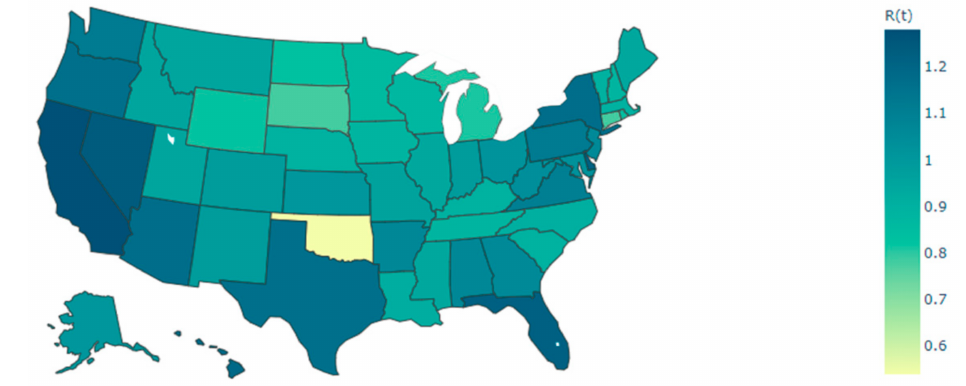
Figure 3. R t determined for all states in the US on 26 November